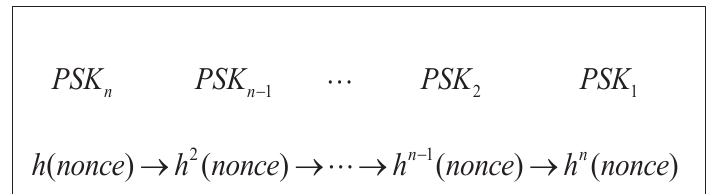
Figure 2. Key set generation scheme based on the hash–chain